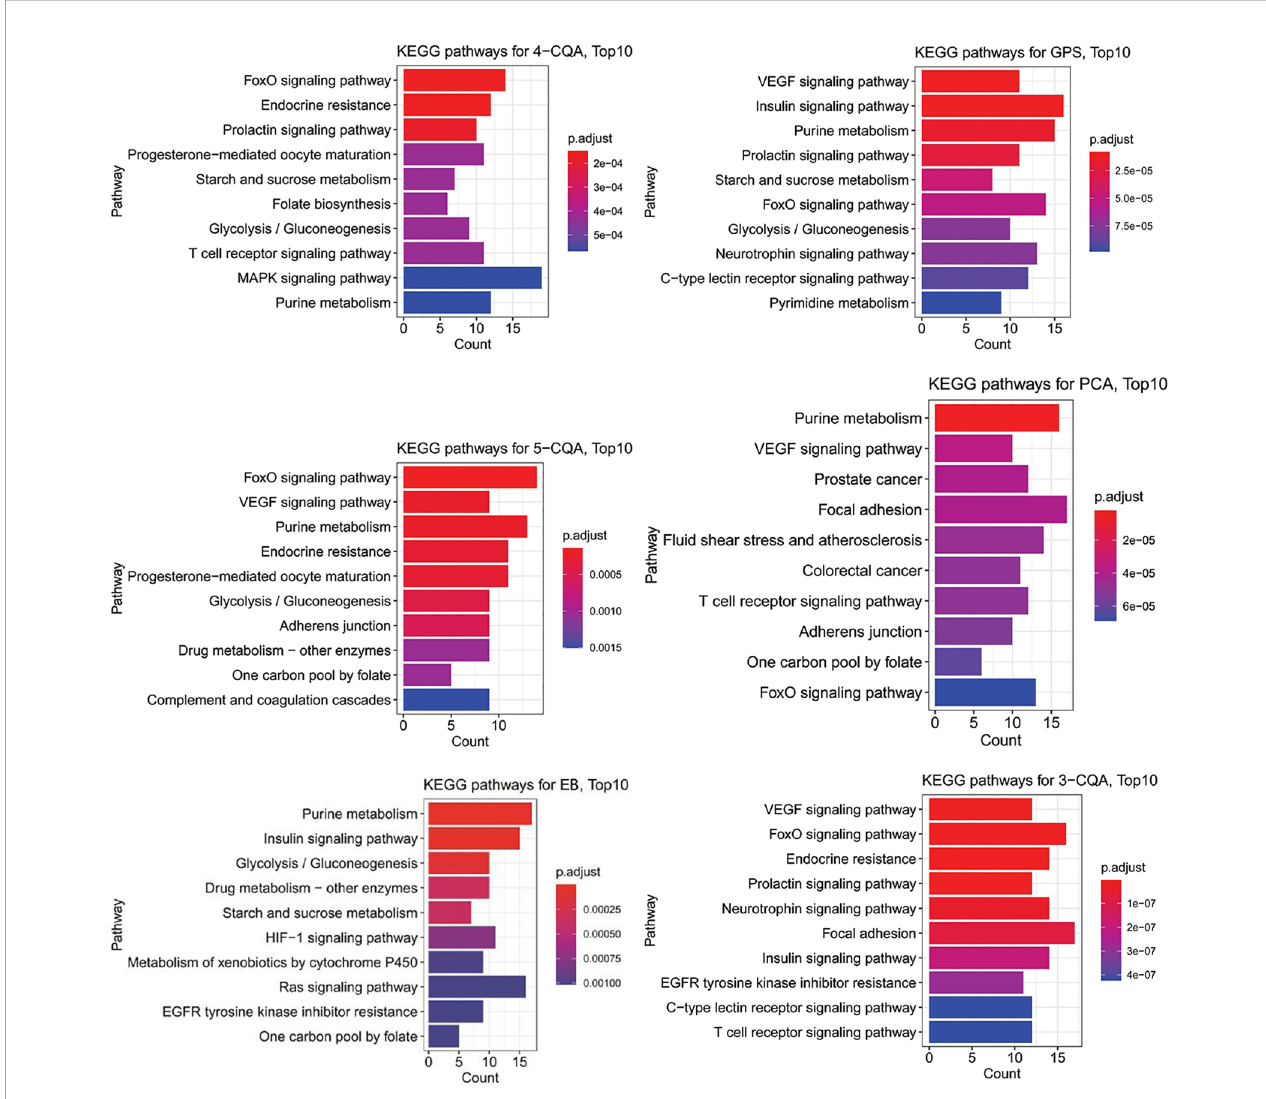
FIGURE 6 | Barplots of KEGG pathway enrichment analysis (top10 results) for the six main ingredients, 4-CQA, gentiopicroside (GPS), 5-CQA, protocatechuic acid (PCA), eleutheroside B (EB), and 3-CQA in Acanthopanax senticosus extract preparation